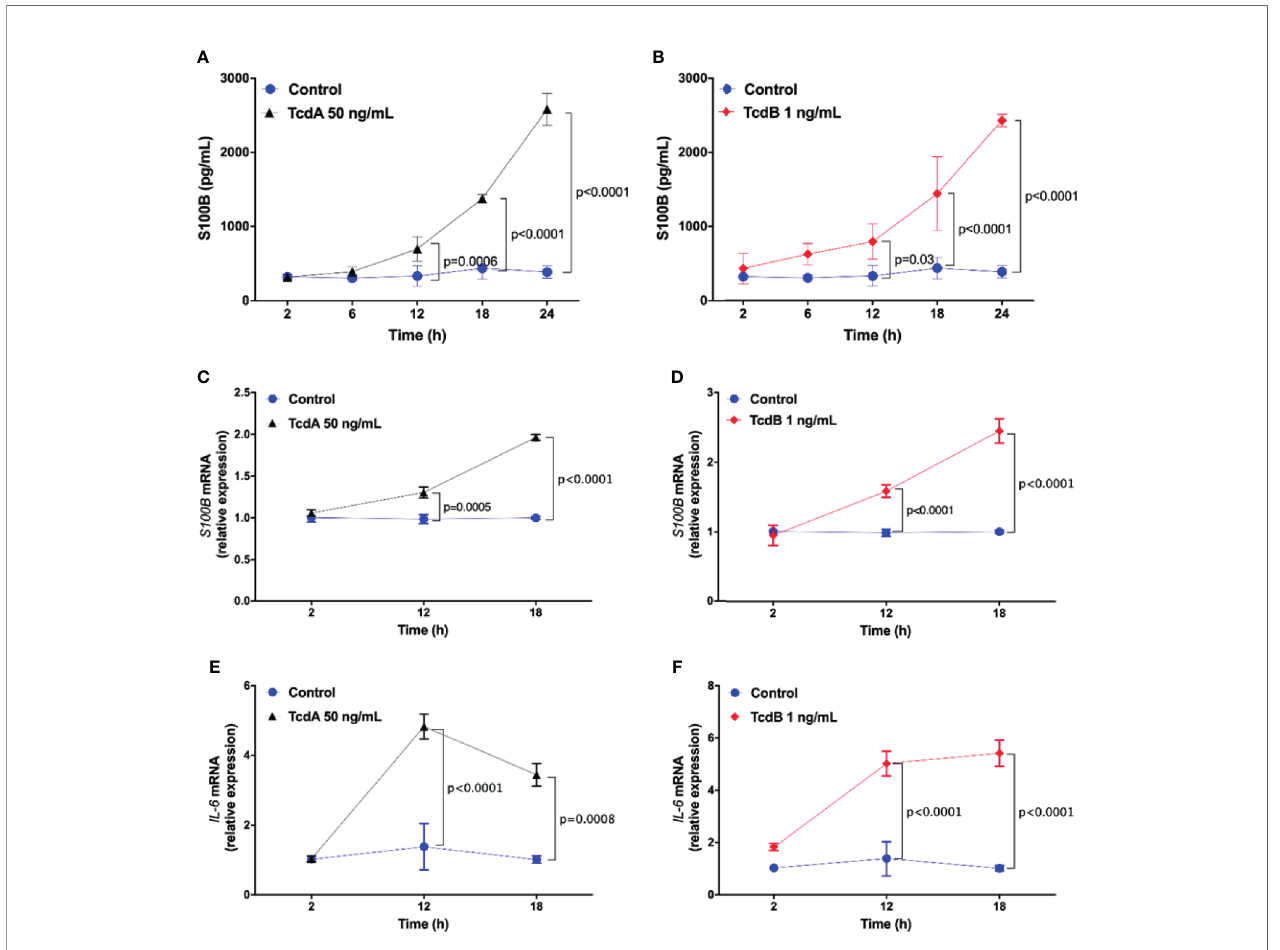
FIGURE 5 | TcdA and TcdB increase S100B-dependent upregulation of IL-6 expression in enteroglial cells (EGC/PK060399). (A, B) Levels of S100B (mean ± s.e.m) released by ELISA, (C, D) S100B , and (E, F) IL-6 gene expression (mean ± s.e.m) by qPCR in enteroglial cells (EGC/PK060399) challenged with (A, C, E) TcdA and (B, D, F) TcdB (n = 4) with TcdA and TcdB (n = 4). (A – F) Cells receiving only supplemented DMEM were applied as a control. (A – F) ANOVA followed by Sidak ’ s multiple-comparison test was